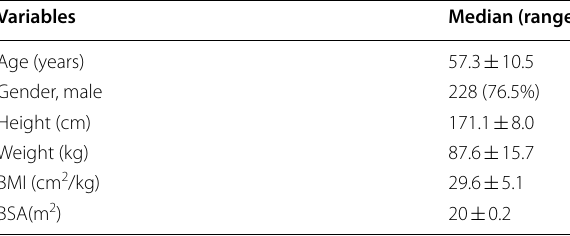
Table 1 Baseline clinical data of the study population